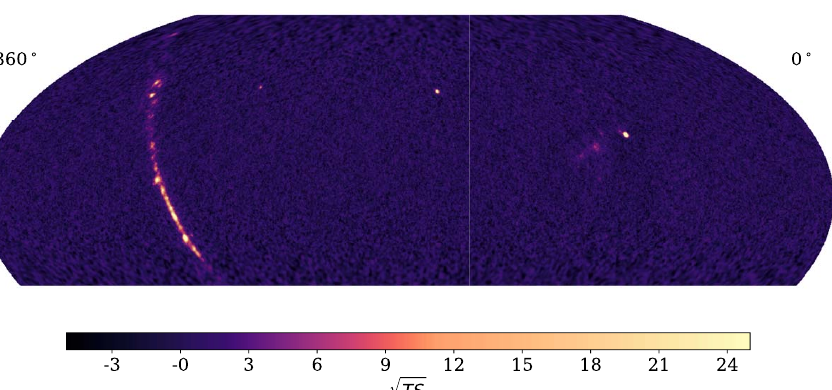
Figure 15. All-sky significance map of the third HAWC Catalogue of Very-high-energy Gamma-Ray Sources. Reproduced from [45].